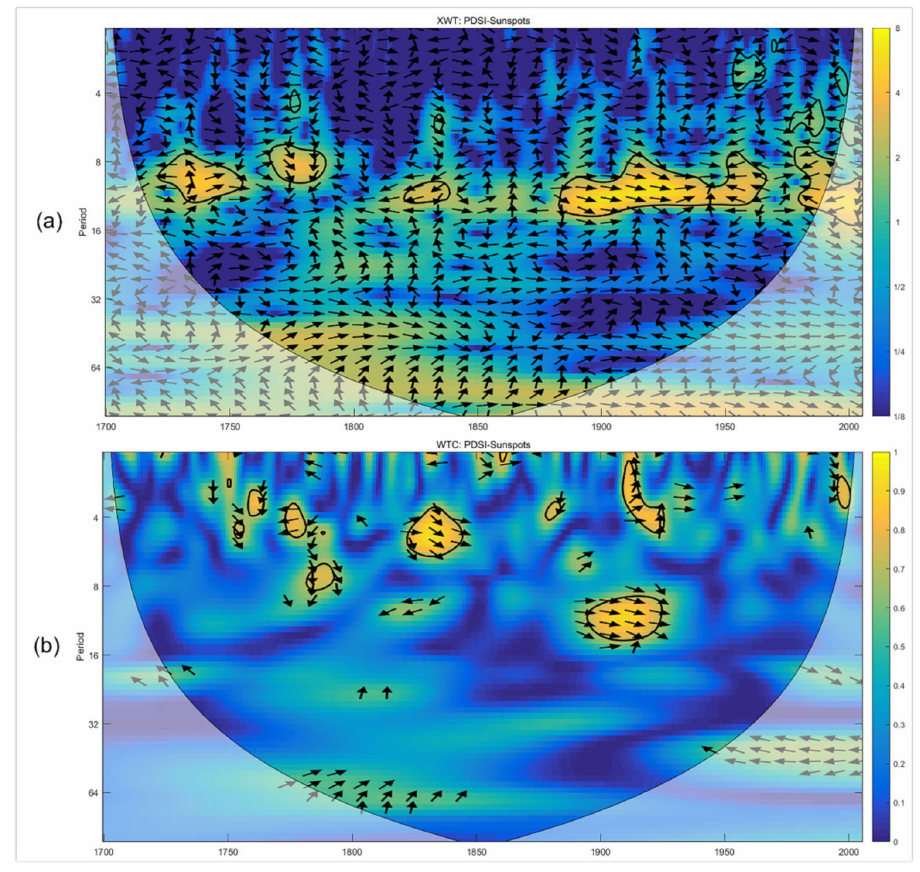
Figure 7. Results of cross wavelet (XWT) and the wavelet coherence (WTC) between the PDSI and sunspot number. ( a ) XWT analysis for investigating the sunspot number affecting PDSI variability; the thick black contour designates the 95% confidence level against yellow noise; the relative phase relationship is shown as arrows (with in-phase pointing right, anti-phase pointing left). ( b ) WTC finds regions in time frequency space where PDSI and sunspots covary; phase arrows indicate the relative phase relationship between the